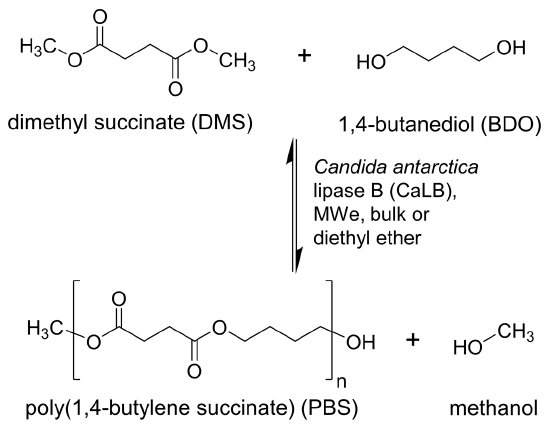
Figure 2. The investigated polycondensation reaction involving the transesterification of dimethyl succinate (DMS) with 1,4-butanediol (BDO) catalyzed by an immobilized preparation of Candida antarctica lipase B (CaLB). Candida antarctica lipase B (CaLB). Table 1. Solvent-free reactions catalyzed by Novozym 435 ® after 4 h @ of reaction. Table 1. Solvent-free reactions catalyzed by Novozym 435 ® after 4 h @ of